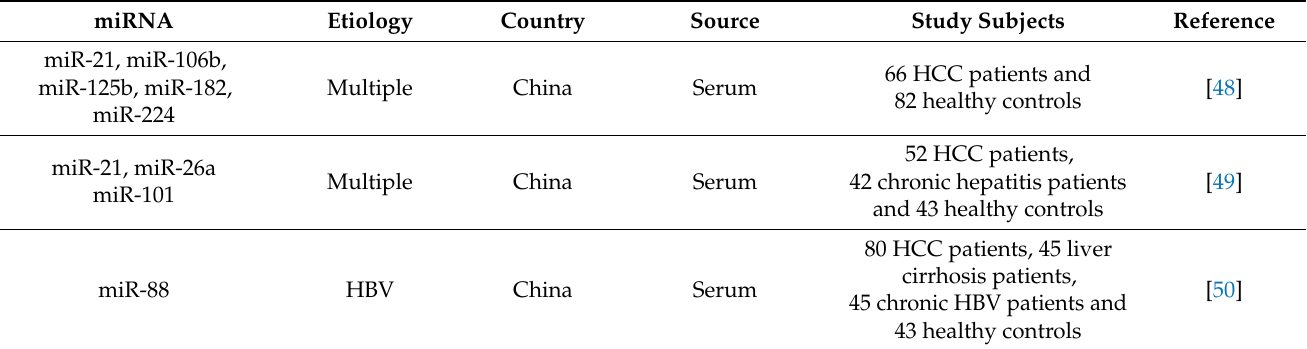
Table 1. Summary of published literature on miRNA evaluation as a biomarker for hepatocellular carcinoma (HCC).